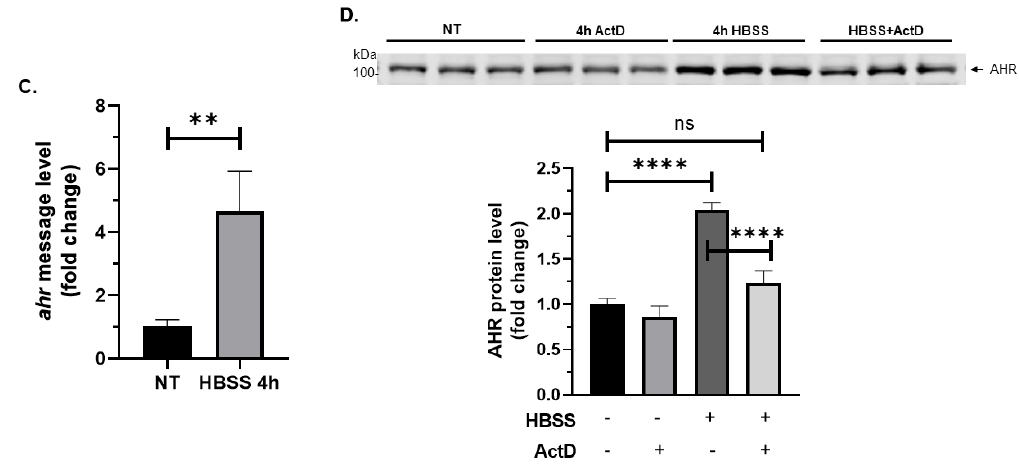
Figure 2. Short-term nutrient deprivation triggers the degradation of AHR in HeLa cells when either Figure 2. Cont. ( C ) A 4 h HBSS treatment significantly increased the ahr message levels in WT HeLa p23 or HSP90 is down-regulated. ( A ) Zero to four hours’ treatment of HBSS (nutrient deprivation) in cells. The graph represents replicate data of means ± SD, n = 3 of one experiment. This experiment wild type (WT), p23 stable knockdown (p23KD), and HSP90 stable knockdown (HSP90KD) HeLa cells. was repeated once with similar results. Data were analyzed by unpaired t -test to determine statistical Fifteen minutes of HBSS treatment decreased AHR protein levels in p23KD and HSP90 HeLa cells but significance. ( D ) Treatment of 5 μ g/mL of actinomycin D (ActD) for 4 h abolished the increase of AHR not in WT HeLa cells. Longer nutrient deprivation of up to 4 h increased AHR protein levels in all protein levels induced by HBSS (nutrient deprivation) in WT HeLa cells. The graph represents three cell lines. The graph represents replicate data of means ± SD (upper error bars shown), n = 3 for replicate data of means ± SD, n = 3 of one experiment. This experiment was repeated once with similar all, except n = 4 for HSP90KD data from 0 to 1 h. Zero timepoints in each cell line were arbitrarily set results. Data were analyzed by one- way ANOVA with Tukey’s multiple comparisons test to as one for comparison. Data were analyzed by unpaired two-tailed t -test for comparisons between determine statistical significance. For A to D, each Western lane contained 30 μ g of whole-cell lysate. zero and 15 min timepoints in each individual cell line (significant data points marked with # symbol). The intensity of all Western bands was normalized by total protein stain. Data were analyzed by two-way ANOVA (mixed-model) analysis corrected with the Dunnett test for multiple comparisons to determine the statistical significance between WT and p23KD or WT and HSP90 KD at each time point (significant data points marked with * symbol). WT HeLa data